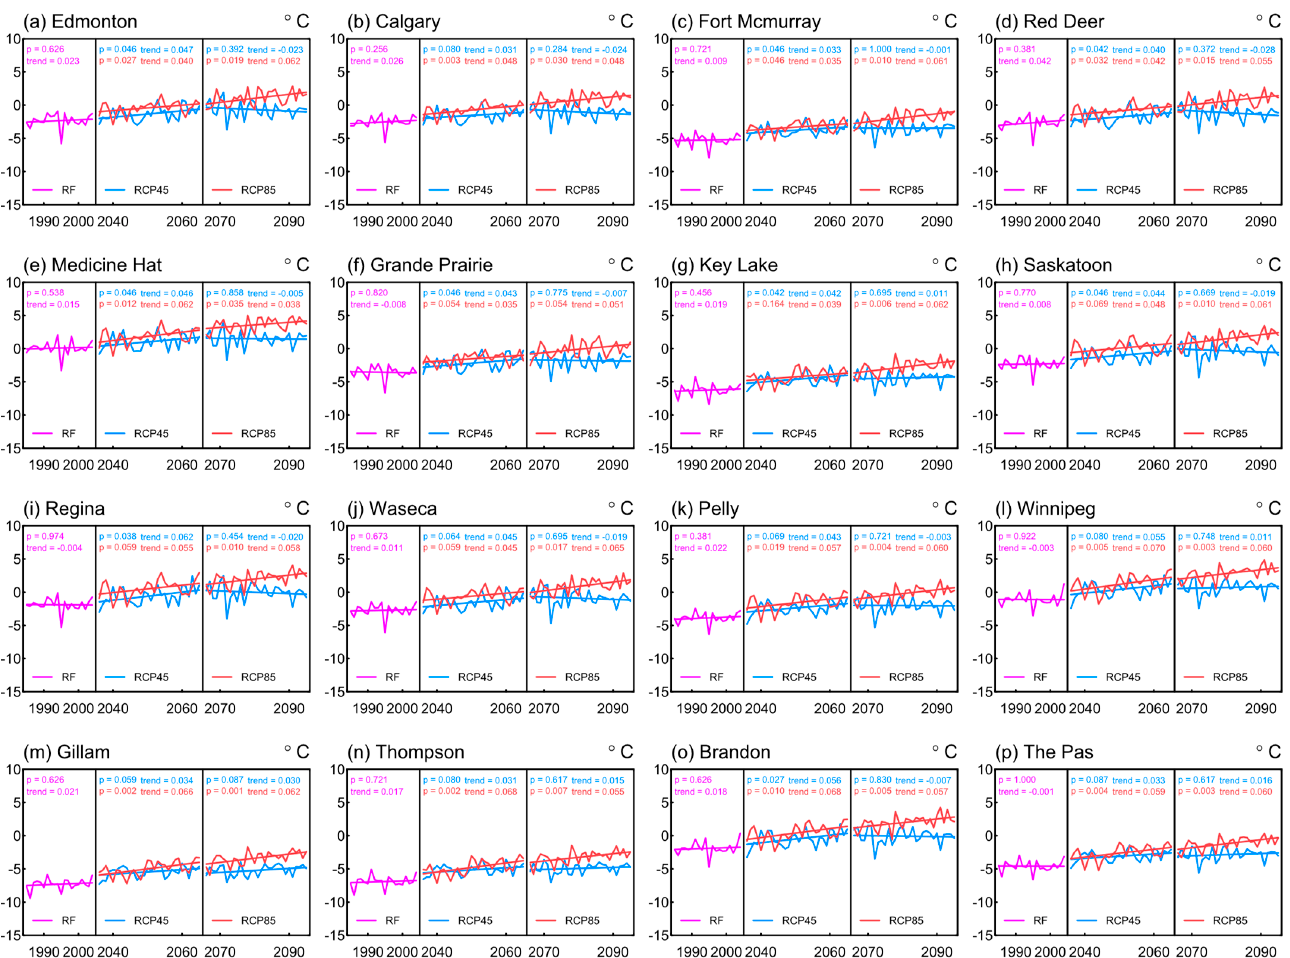
Figure 11. Temporal trends in annual averages of T min at the 16 stations. The value of p and trend is derived from the MK test and the Theil–Sen estimator, respectively. The straight line represents the linear trend derived from the Theil–Sen estimator. ( a ) Edmonton, ( b ) Calgary, ( c ) Fort Mcmurray, ( d ) Red Deer, ( e ) Medicine Hat, ( f ) Grande Prairie, ( g ) Key Lake, ( h ) Saskatoon, ( i ) Regina, ( j ) Waseca, ( k ) Pelly, ( l ) Winnipeg, ( m ) Gillam, ( n ) Thompson, ( o ) Brandon, and ( p ) The Pas.